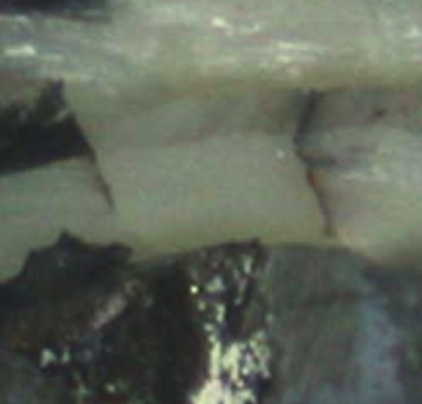
Figure 4: Picture showing a 2 score of microleakage (left) and 4 score of microleakage